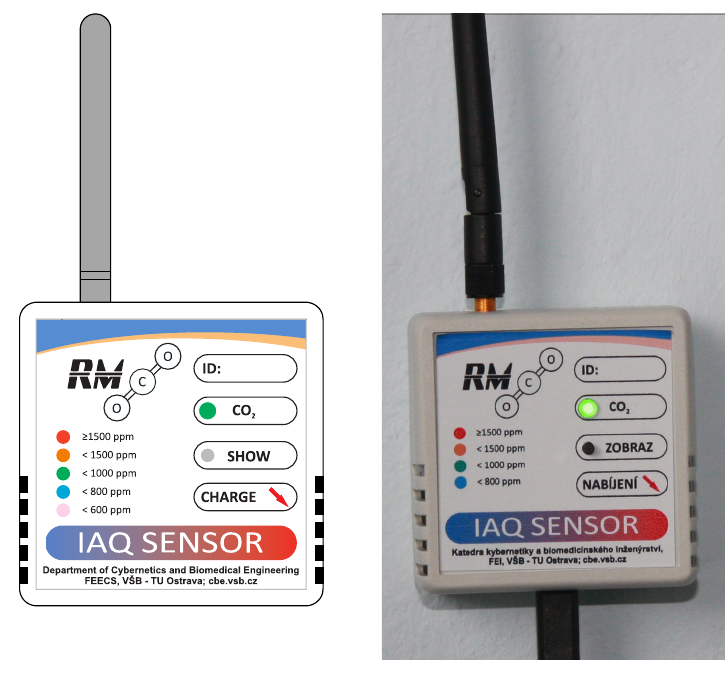
Figure 1. Diagram and photograph of installed RMCD device.